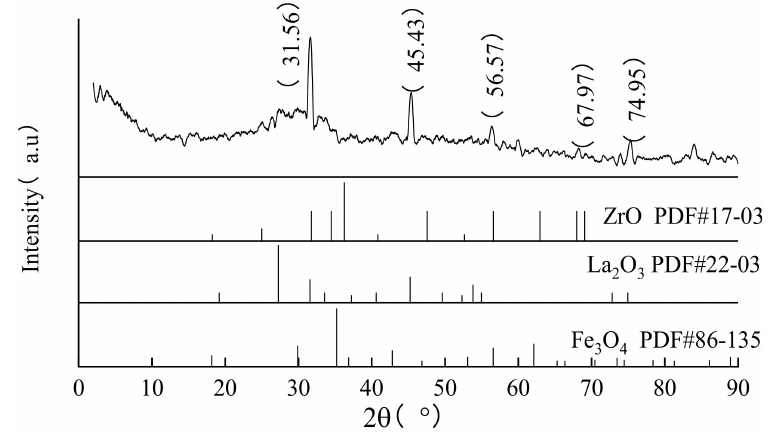
Figure 1. XRD pattern of composite adsorbent and standard card.